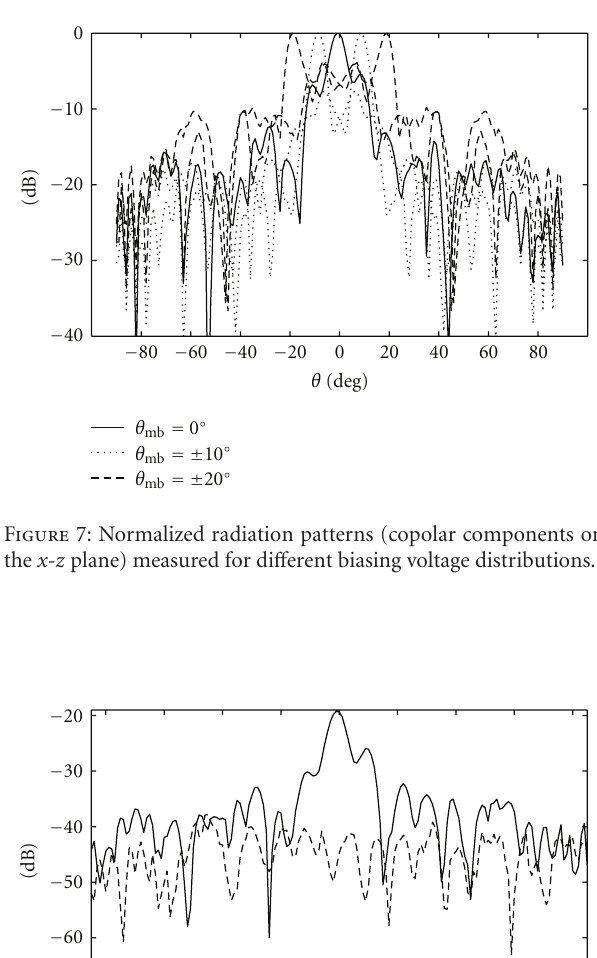
Figure 9: Measured radiation pattern (copolar and cross-polar components on x-z plane) for a main beam θ mb = 10 ◦